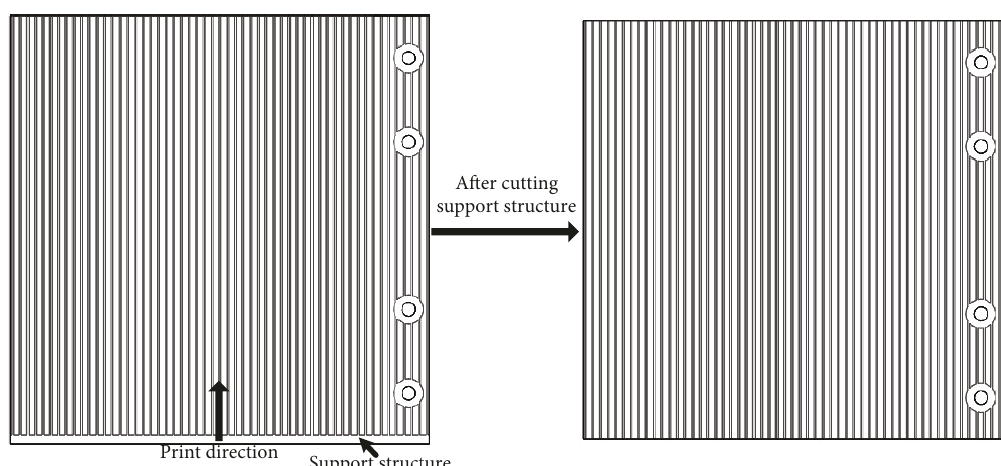
Figure 12: The print direction of the new type of solar panel and after cutting the support